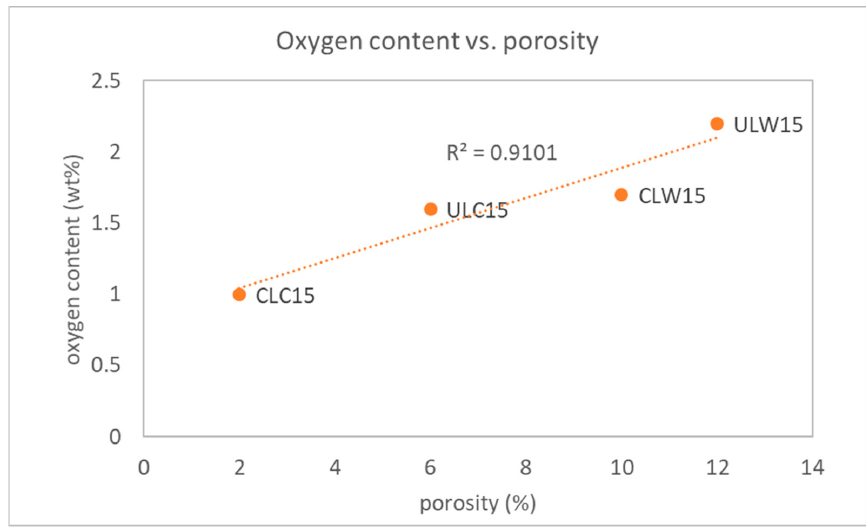
Figure 13. Correlation of porosity (Figure 8) with oxygen content (determined by EDS on the fracture surfaces, Table